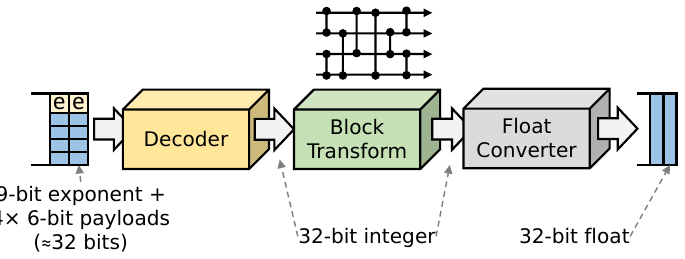
Figure 3. A diagram of overall architecture.